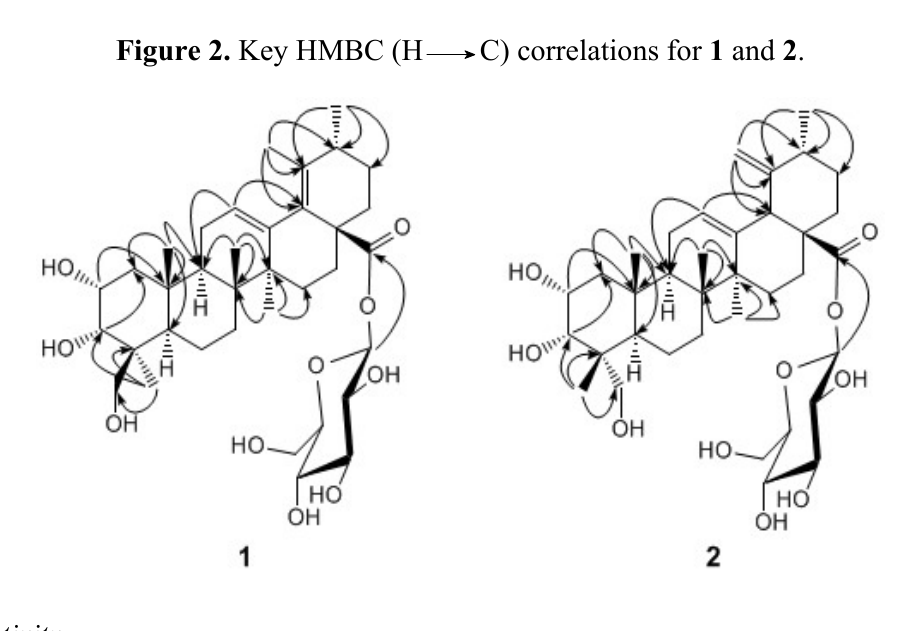
Figure 2. Key HMBC (H C) correlations for 1 and 2